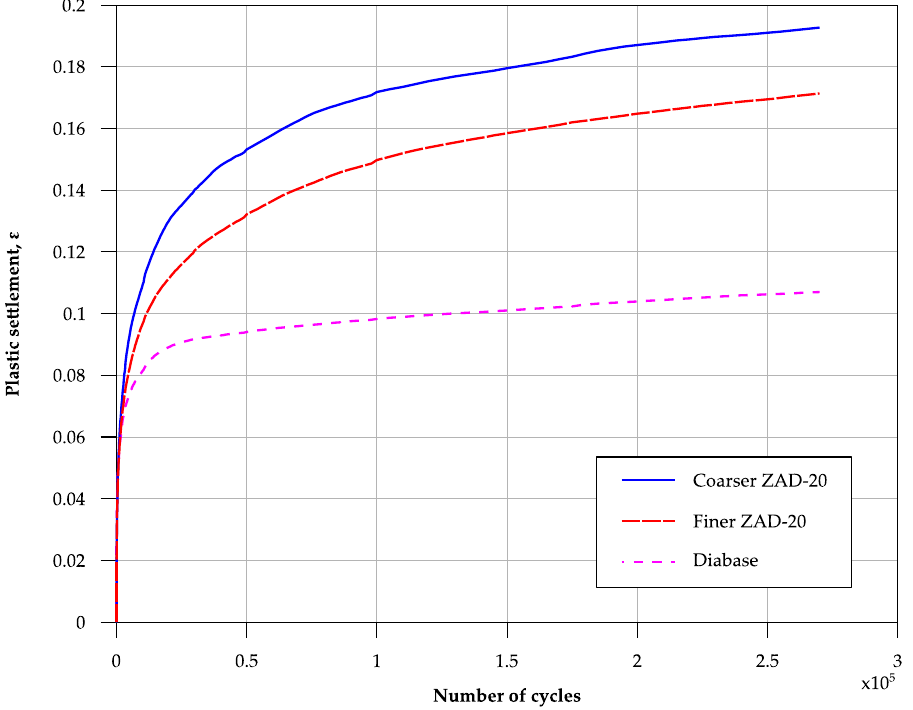
Figure 6. Evolution of the plastic settlement with the number of cycles.